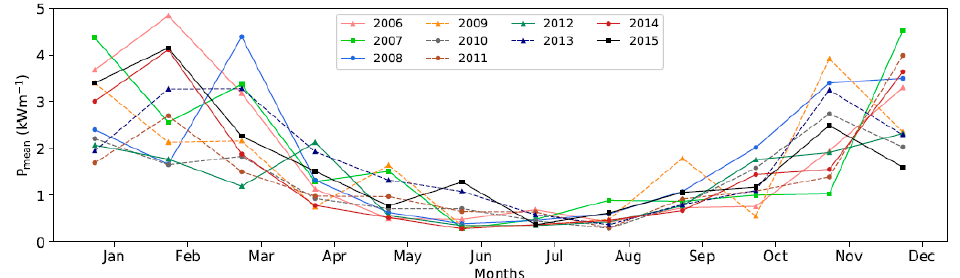
Figure 8. Yearly time series of the monthly variations of predicted available wave power averaged along the line offshore from the harbour breakwater.